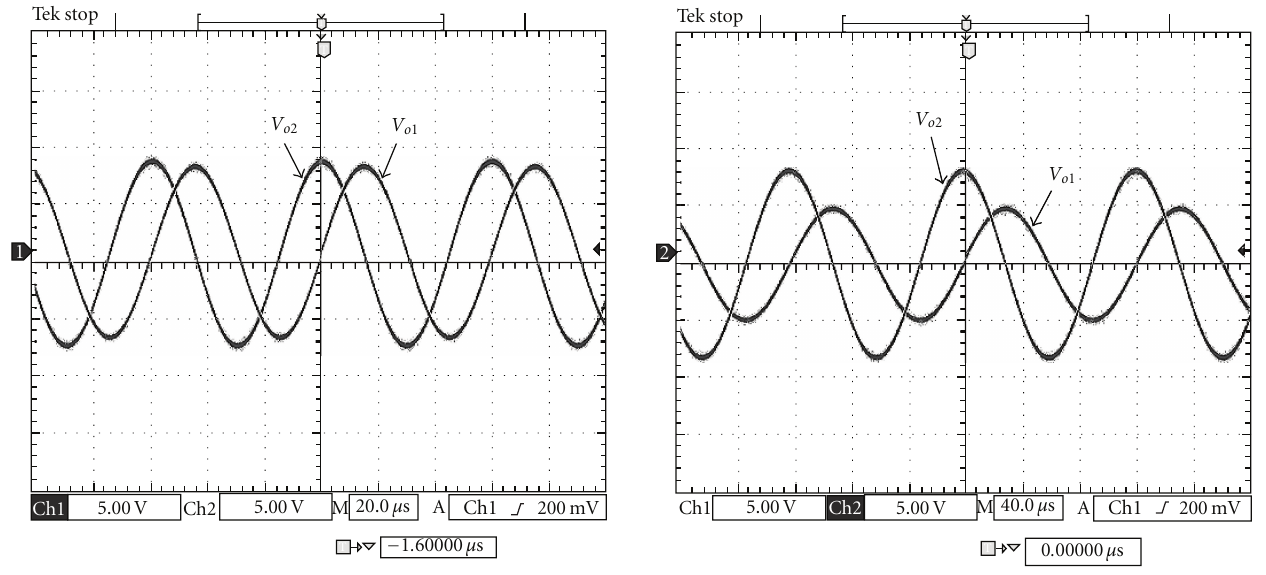
Figure 5: The experimental quadrature output waveforms of Figure 2.